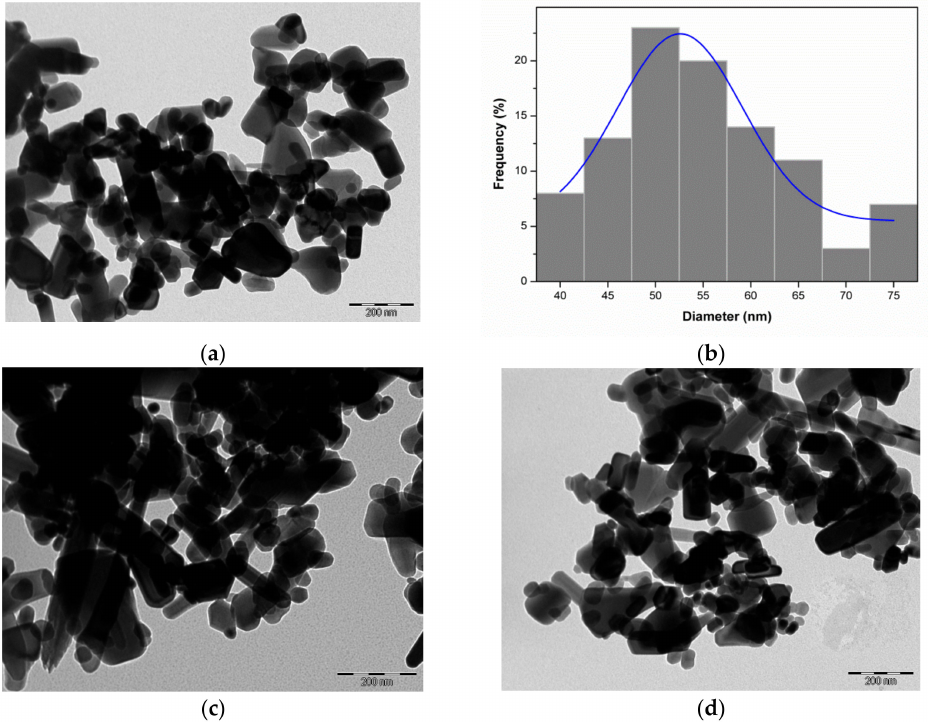
Figure 4. TEM image of bare ZnO ( a ) and sample size distribution ( b ); and TEM images of H 2 Pp–ZnO ( c ) and CuPp–ZnO ( d ).